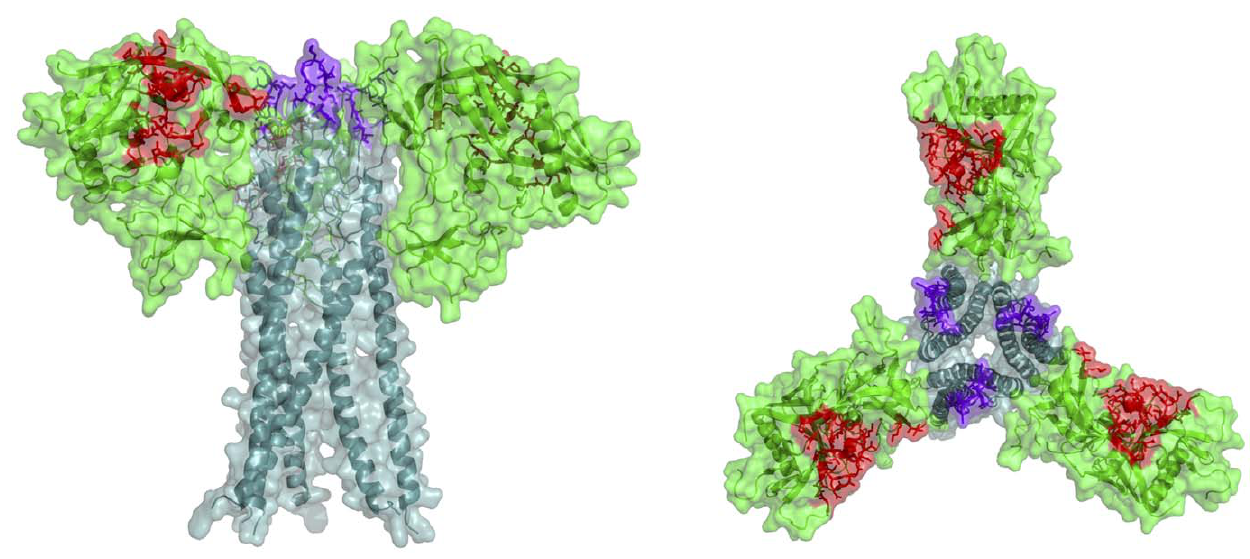
Figure 8. Model of Env showing Ab binding sites. Gp120 is shown in green with the variable loops deleted, gp41 in blue, the HY epitope in red, and 7B2 in violet. Molecular modeling was performed starting with the crystal structures of gp120 [67,68] and homology model of HIV gp41. The sequence of HIV gp41 clade B was built onto the homologous NMR structure of SIV gp41 [69] using Modeller [70], allowing the structure of the loop region of HIV gp41, and thus the location of the 7B2 epitope, to be approximated. The relative position of the gp120 trimer to the gp41 trimer was constructed by searching through the rotational and translational degrees of freedom about the threefold symmetry axis. The structure shown is the complex with the lowest potential energy using the Amber03 Forcefield [71]. A thorough description of the modeling protocols and energetic analyses will be published elsewhere (M.A. Zubieta and C.M. Summa, manuscript in preparation).